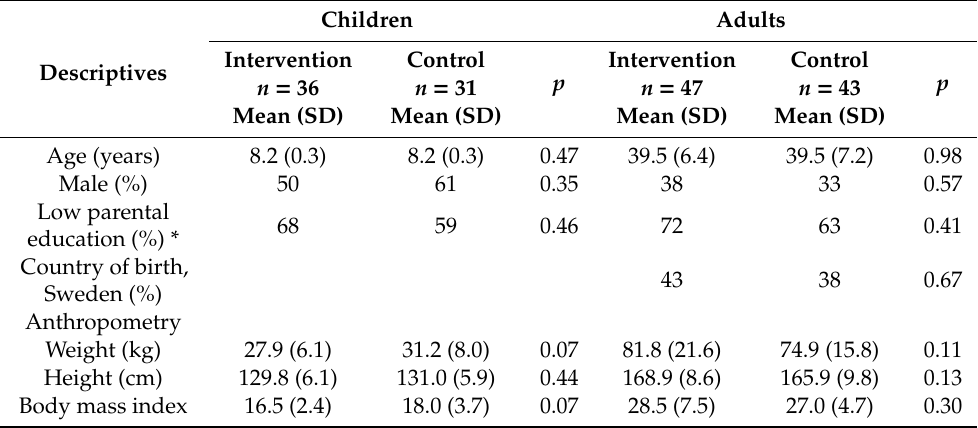
Table 1. Descriptive characteristics at baseline categorized by intervention and control and by children and